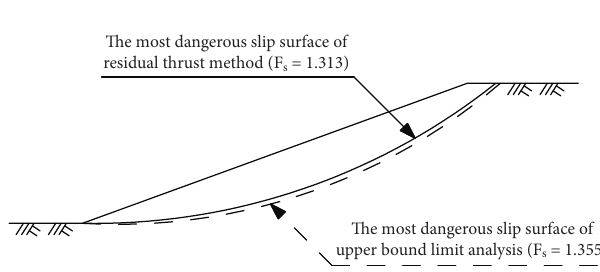
Figure 6: Most dangerous slip surface